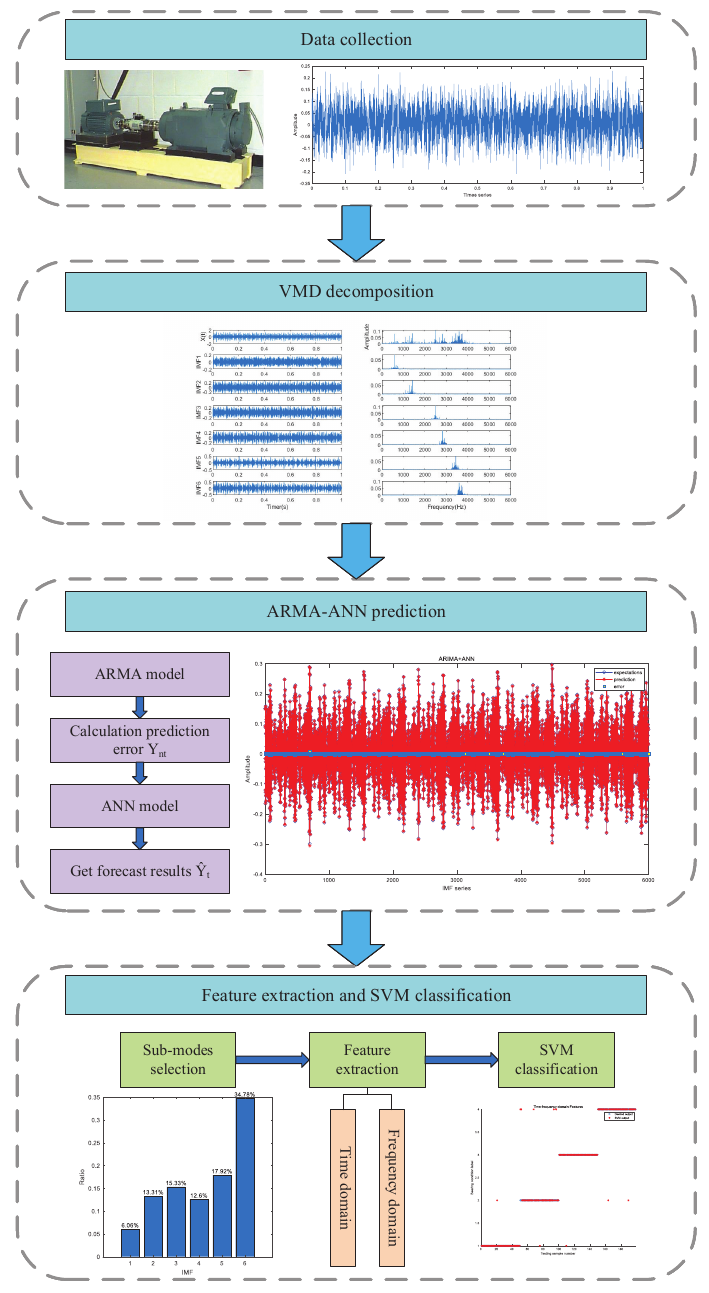
Figure 2. The architecture of the proposed condition monitoring